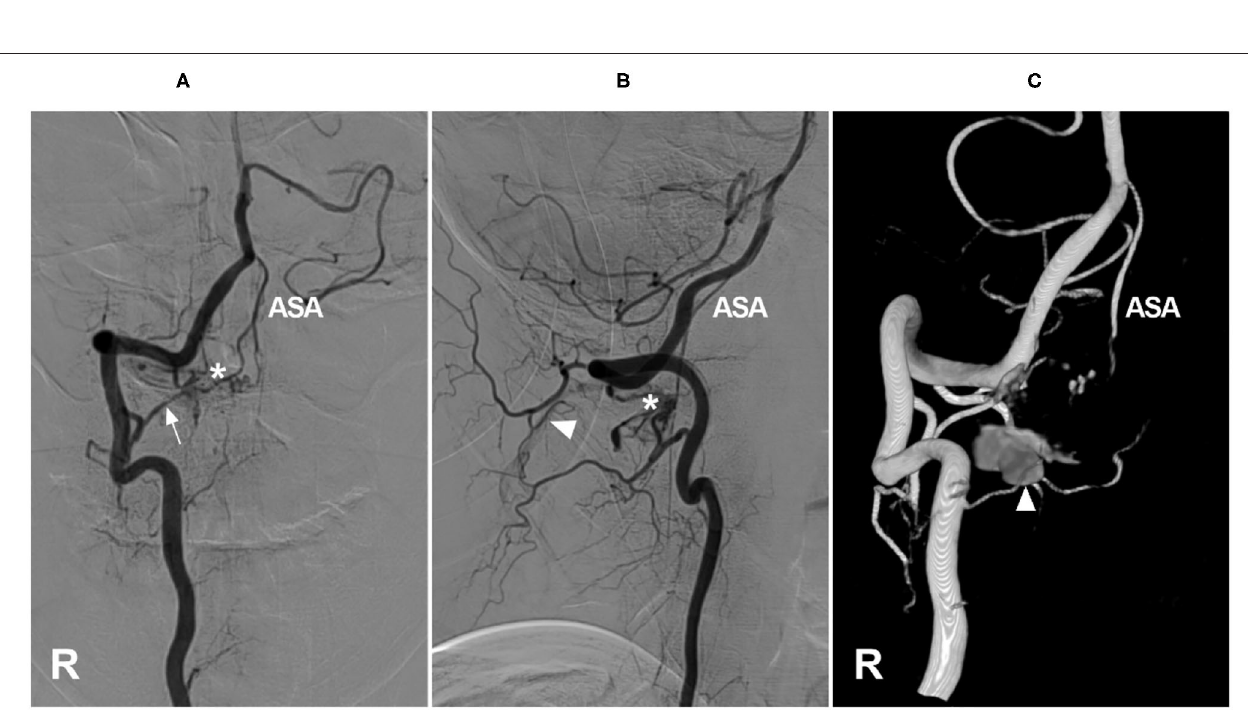
Frontiers in Neurology | www.frontiersin.org